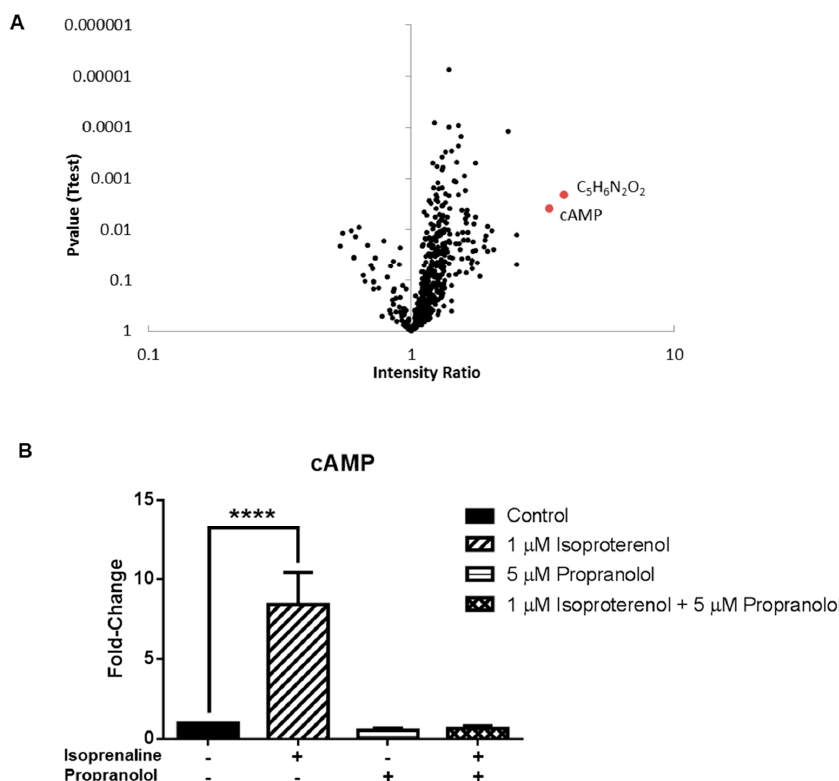
Figure 7 . Detection of cAMP accumulation in untargeted metabolomics analysis. ( A ) Volcano plot showing metabolite abundance (LC-MS peak height) relative to untreated controls ( x -axis) and p -value from Welch’s test ( y -axis) for all metabolites (black circles) in MDA-MB-231 cells treated with isoproterenol for 4 h, compared to untreated control cells. Metabolites with a fold-change >3 and p -value <0.05 are shown in red ( B ) cAMP abundance from cells treated with isoproterenol and/or propranolol for 4 h shown as LC-MS peak area relative to untreated control cells (mean ± SE, n = 4). **** p ≤ 0.0001, using one-way ANOVA with Dunnett’s multiple comparison test.